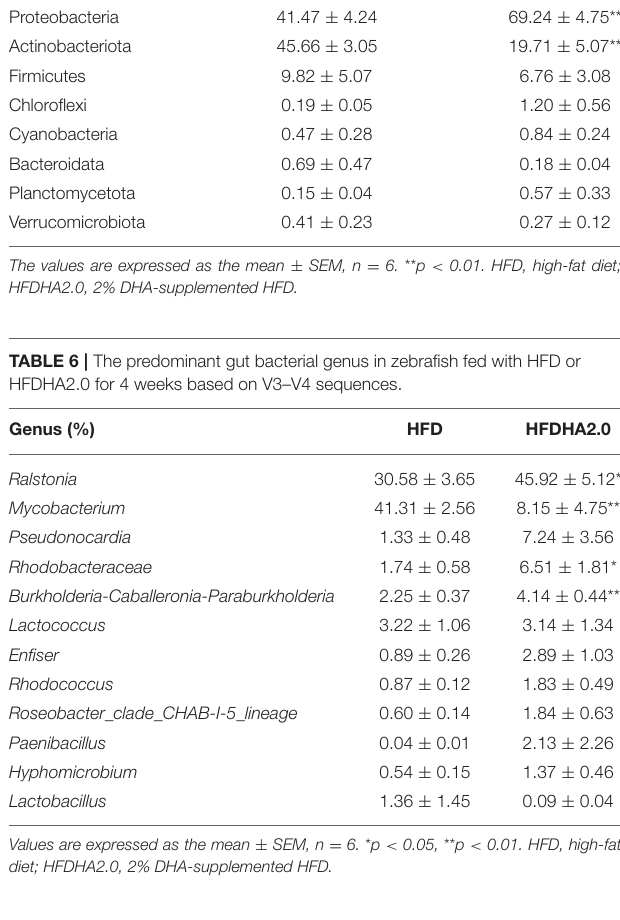
TABLE 5 | The predominant gut bacterial phylum in zebrafish fed with HFD or HFDHA2.0 for 4 weeks based on V3–V4 sequences. Phylum (%)